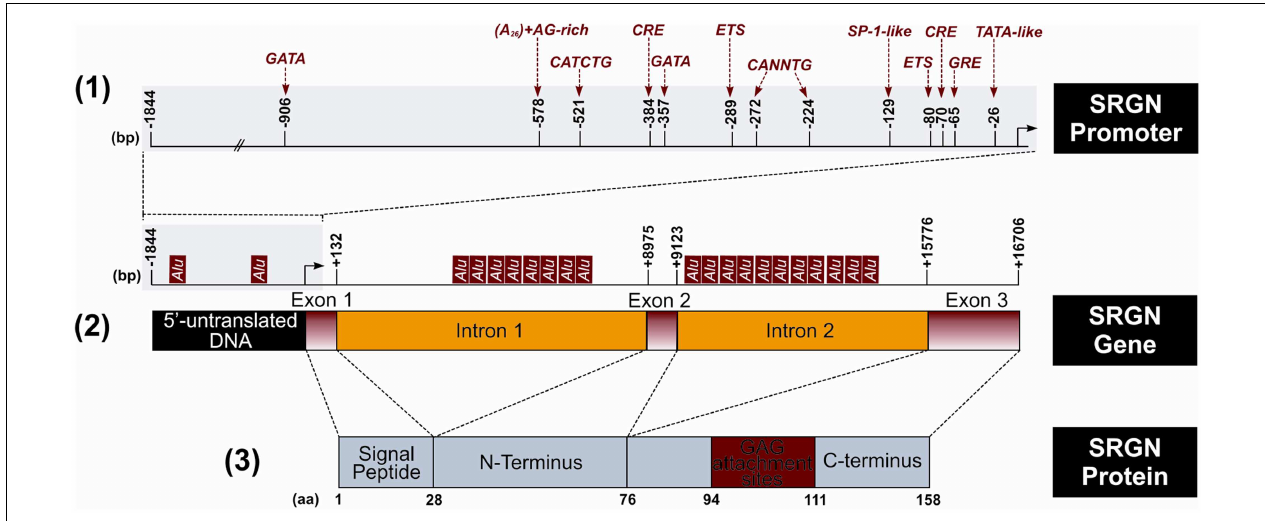
FIGURE 1 | Schematic representation of the structure of human serglycin (SRGN) gene and protein . (1) Putative regulatory sites in SRGN promoter. Glucocorticoid response element (GRE), specificity protein-1 (SP-1). (2) Location of the Alu elements in the SRGN gene. (3) Encoded SRGN core protein. (bp, base pairs; aa,